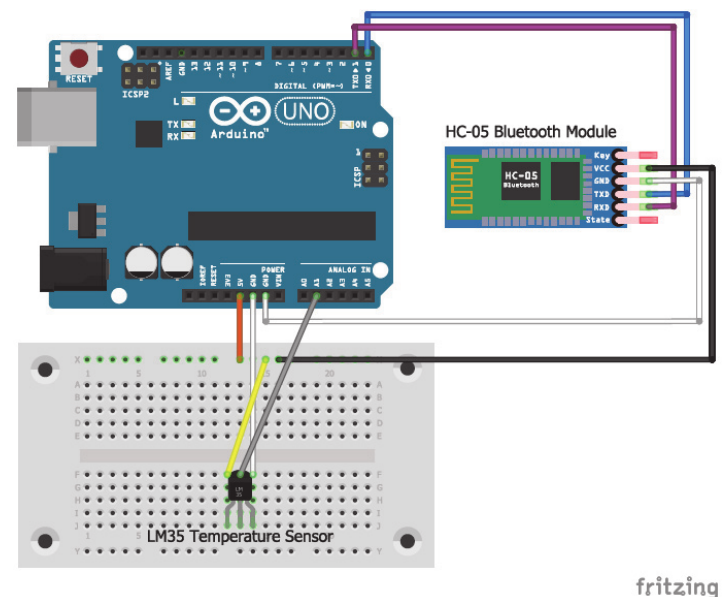
Figure 9: Scheme of sensor configuration.